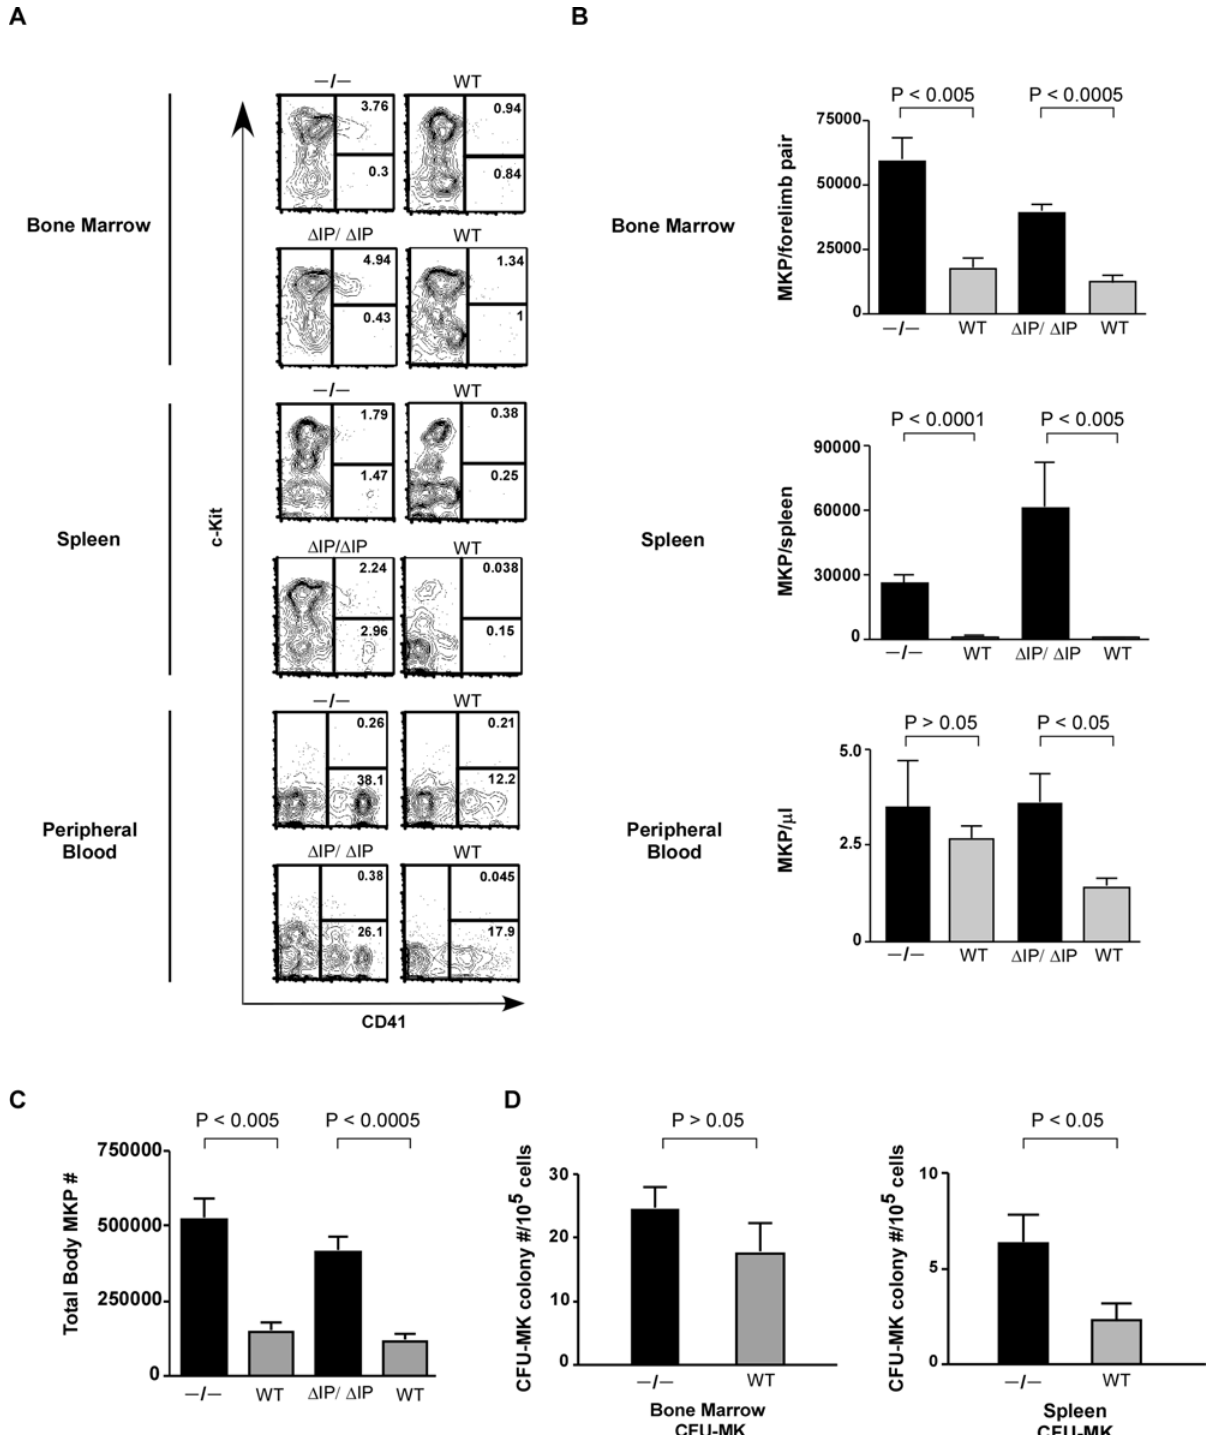
Figure 2. SHIP deficient mice have increased number of functional MKP in hematopoietic organs. (A) BM, spleen, and PB MKP phenotype in SHIP 2 / 2 ( 2 / 2 ) and SHIP D IP/ D IP ( D IP/ D IP) mice. Shown are representative flow cytometry dot plots of CD41 ( x -axis) versus c-Kit ( y -axis) after gating on live and Lin 2 cells. MKP (Lin 2 c-Kit + CD41 + ) are represented in the right upper quadrants and MK (Lin 2 c-Kit 2 CD41 + ) are represented in the right lower quadrants. Percentages for each population are indicated on each plot. (B) Represented are the mean 6 standard error mean (SEM) (n=4 for experimental groups WT C57Bl6 and SHIP 2 / 2 , while n=6 for experimental groups WT 129SvJ and SHIP D IP/ D IP ) of the absolute numbers of MKP in BM, spleen and PB of SHIP deficient mice (black columns) compared to respective WT littermates (gray columns). Mice strains specified in the graphs. (C) Represented is the mean 6 SEM (n=4 for experimental groups WT C57Bl6 and SHIP 2 / 2 , while n=6 for experimental groups WT 129SvJ and SHIP D IP/ D IP ) of total body MKP numbers determined as the calculated sum of MKP in one whole spleen plus MKP in one femur 6 16.6 (since one femur is estimated to contained 6% the total marrow) [3]. (D) Represented is the mean 6 SEM of CFU-MK colonies in BM and spleen of SHIP 2 / 2 (n=7) and WT (n=7) littermates. Statistical analysis was established using the Mann-Whitney test. p values indicated on each graph.